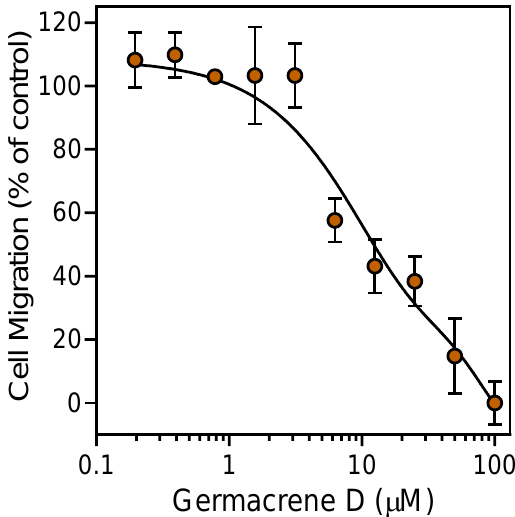
Figure 5. Inhibition of neutrophil chemotaxis by germacrene D. Neutrophil migration toward 1 nM f MLF was measured, as described in Section 2. The data are presented as the mean ± S.D. (N = 3) from one experiment that is representative of two independent experiments.